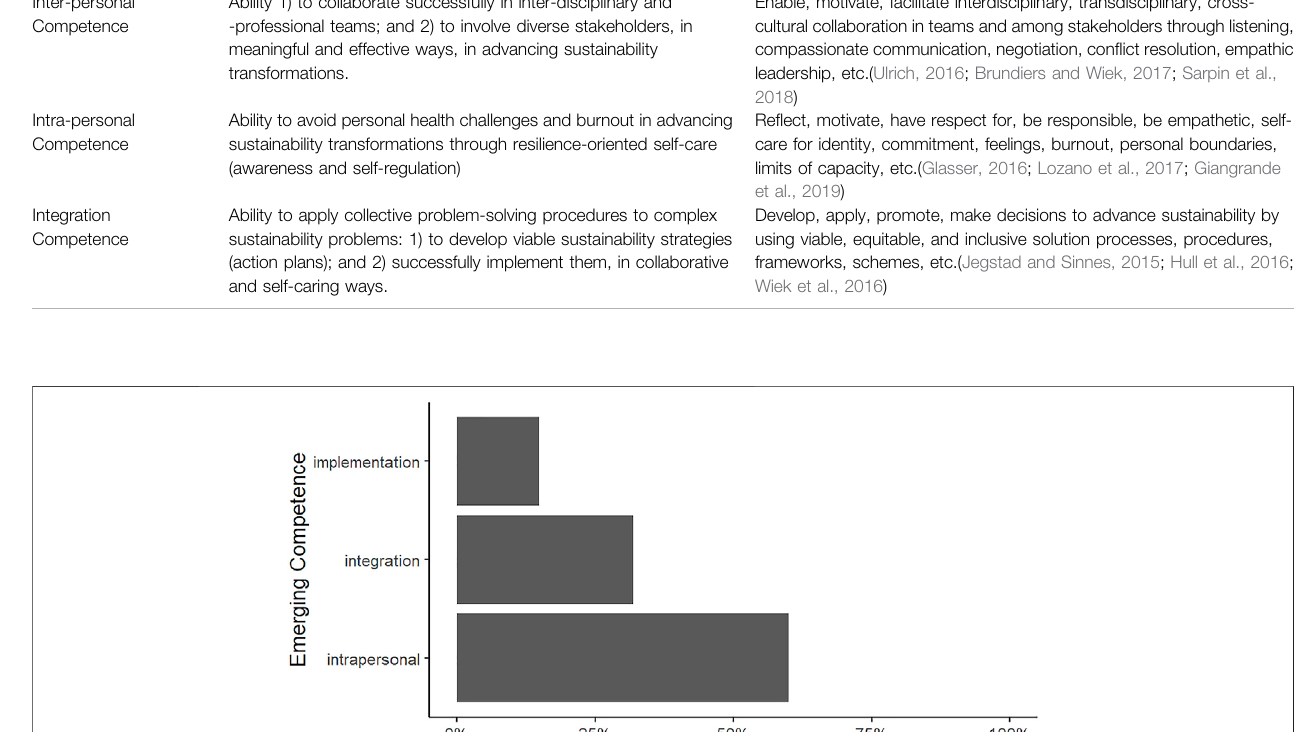
Frontiers in Education |